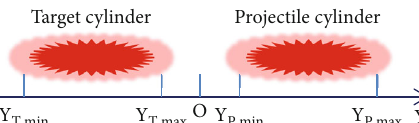
Figure 2: The relative positions of y in the rapidity space. The projectile cylinder is assumed to appear on the right side, while the target cylinder appears on the left